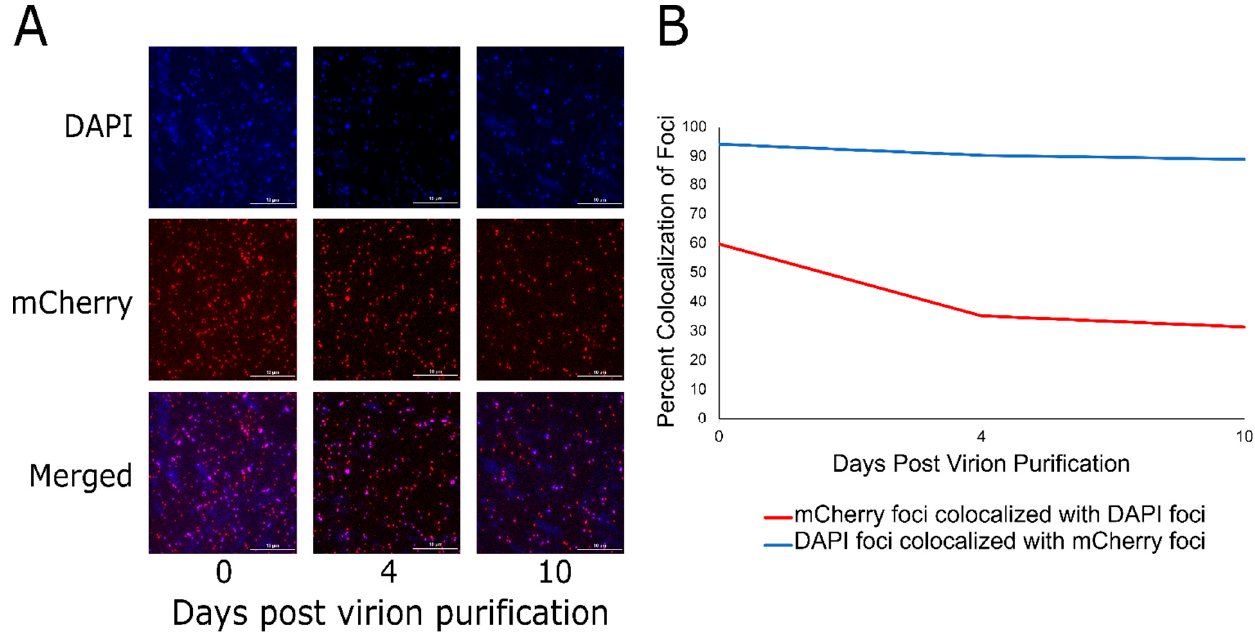
Figure 4. The 30 N-terminal residues of DarB are sufficient to target TetR-mCherry to the P1 capsid. ( A ) The simultaneous induction of the pBAD24_N30-tetR-mCherry expression vector and the P1 Δ darB lysogen results in the localization of TetR-mCherry to the P1 capsid. Fluorescence imaging of CsCl-purified P1 Δ darB + TetR-mCherry virions over days 0, 4, and 10 are shown using a DAPI filter, mCherry filter, and the two channels merged. ( B ) The line graph illustrates the colocalization of DAPI and mCherry foci over the 10 days post-purification of the P1 Δ darB + TetR-mCherry virions. The red line indicates the percent colocalization of mCherry foci with DAPI foci, and the blue line indicates the percent colocalization of DAPI foci with mCherry foci. This indicates that most (~90%) particles with packaged DNA contain TetR-mCherry, but many particles containing TetR-mCherry do not contain DNA; this may be due to particle instability or premature DNA ejection from the virions during storage.